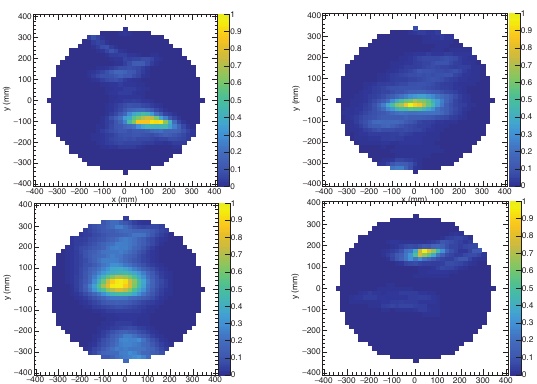
Fig. 9. Examples of projected 2-cm thick horizontal slices of the full3Dimageforfour differentlegacywastedrumsattheSVAFO facility in Studsvik, Sweden. Each slice is applied at the vertical position of the maximum detected concentration of spontaneous fission activity. See text for details and reference